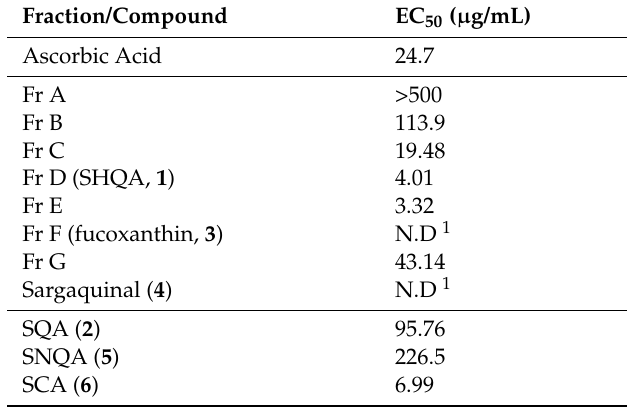
Table 1. DPPH radical scavenging activity of S. incisifolium fractions, compounds and analogs.